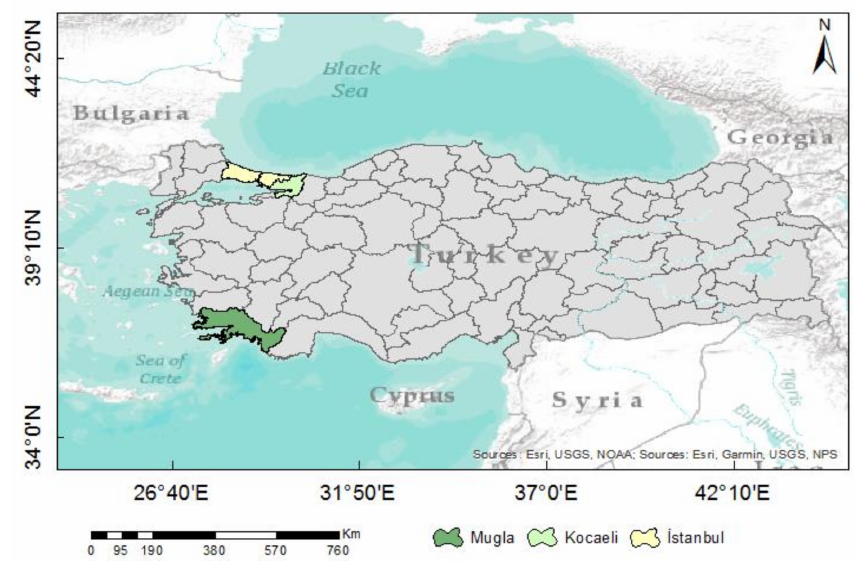
Figure 1. Distribution of selected cities for study area in Turkey.